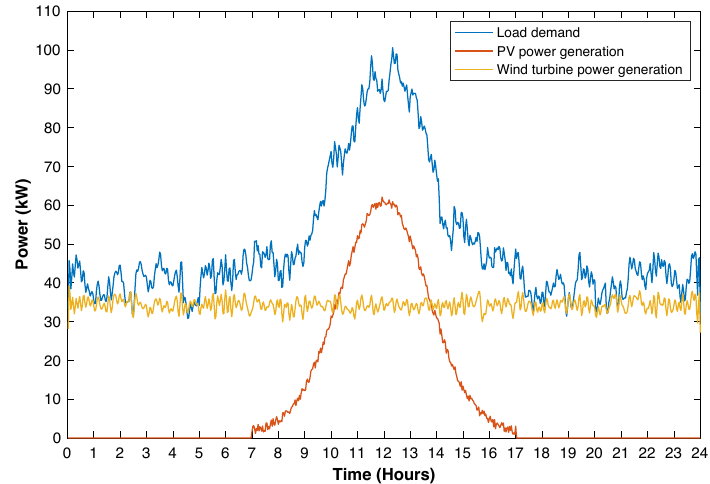
Figure 6. Industrial load, PV source and WT powers taken from